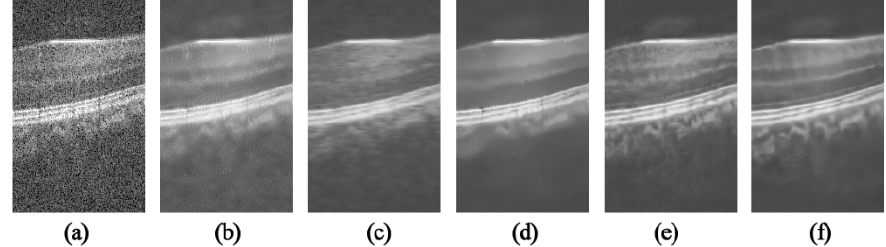
Figure 7. Comparison of local layered structures of the green box in Figure 5. ( a ) Noisy image (256 × 160), results by ( b ) TNode, ( c ) SBSDI, ( d ) PNLM, ( e ) DIP, ( f ) NLM-DIP.